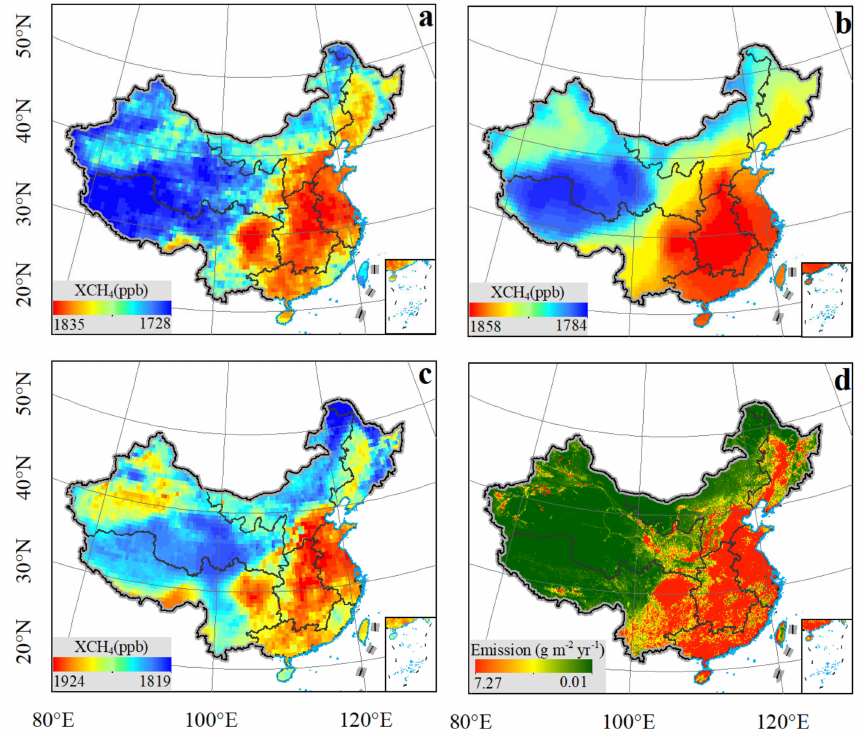
Figure 3. Spatial distribution of multi-year averages of atmospheric XCH 4 and CH 4 emissions over all of China. ( a ) XCH 4 concentrations from SCIAMACHY (January 2003 to December 2010); ( b ) XCH 4 concentrations from GOSAT (January 2011 to December 2018); ( c ) XCH 4 concentrations from S5P (January 2019 to December 2021); and ( d ) CH 4 emission from EDGAR (2003 to